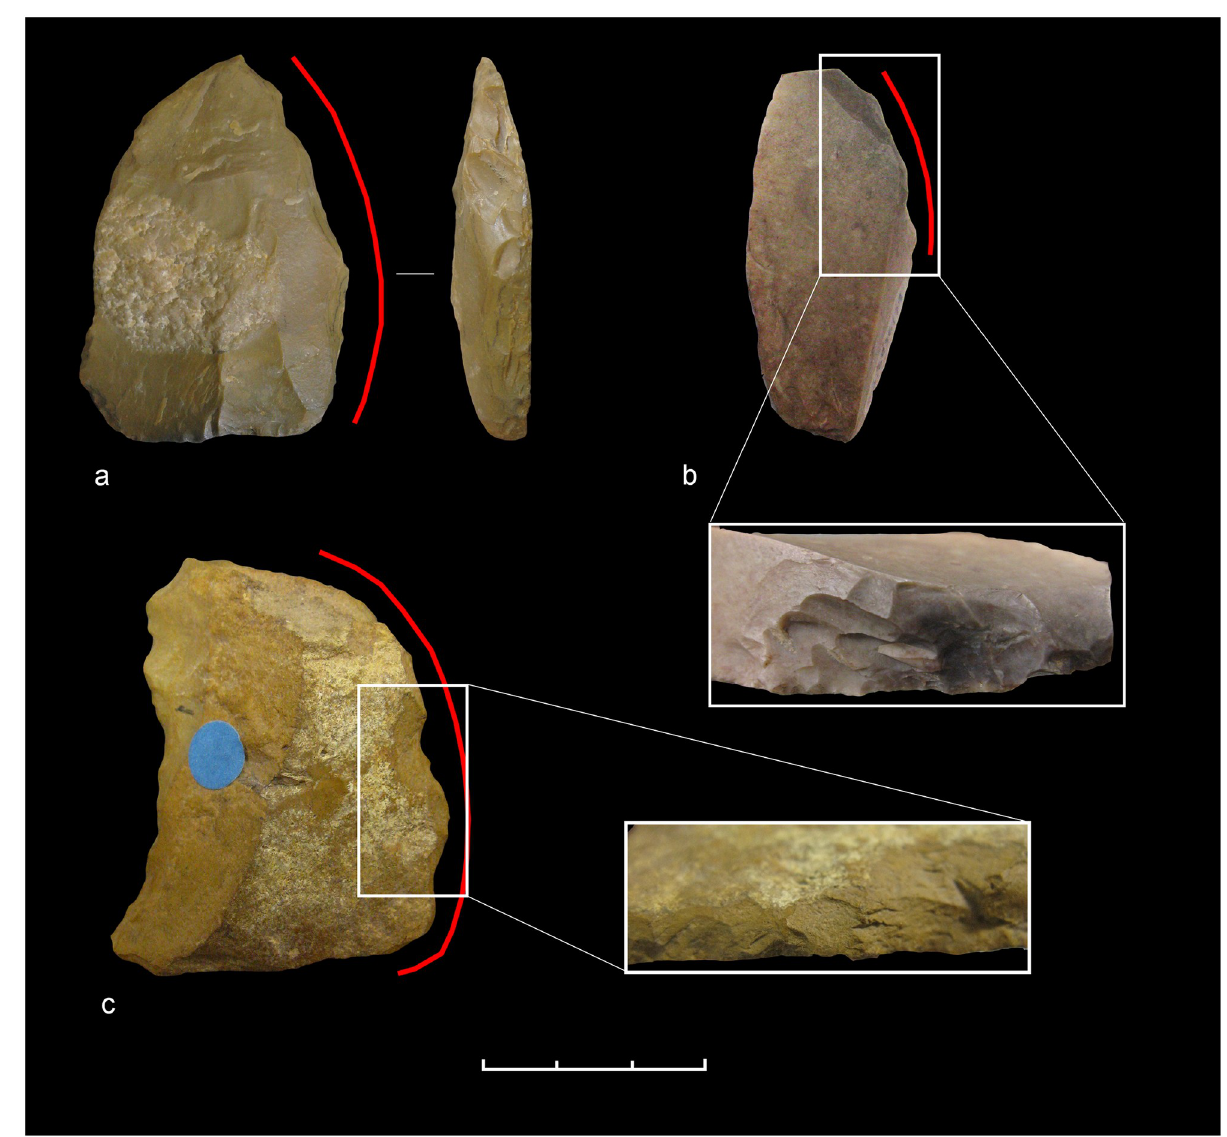
Fig 9. Scrapers showing prepared back by means of total (a, c) or partial (b) direct retouch. The specimens are S8918/73(a), S6436/71(b), P1551/S64 (c).